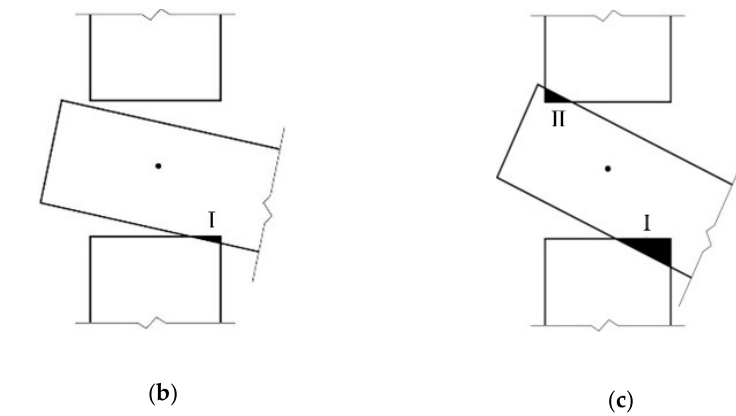
Figure 4. Mechanical analysis of SMTJ/WP: ( a ) free rotation; ( b ) Area I entering compression state; ( c ) Area I and Aea II entering compression state.